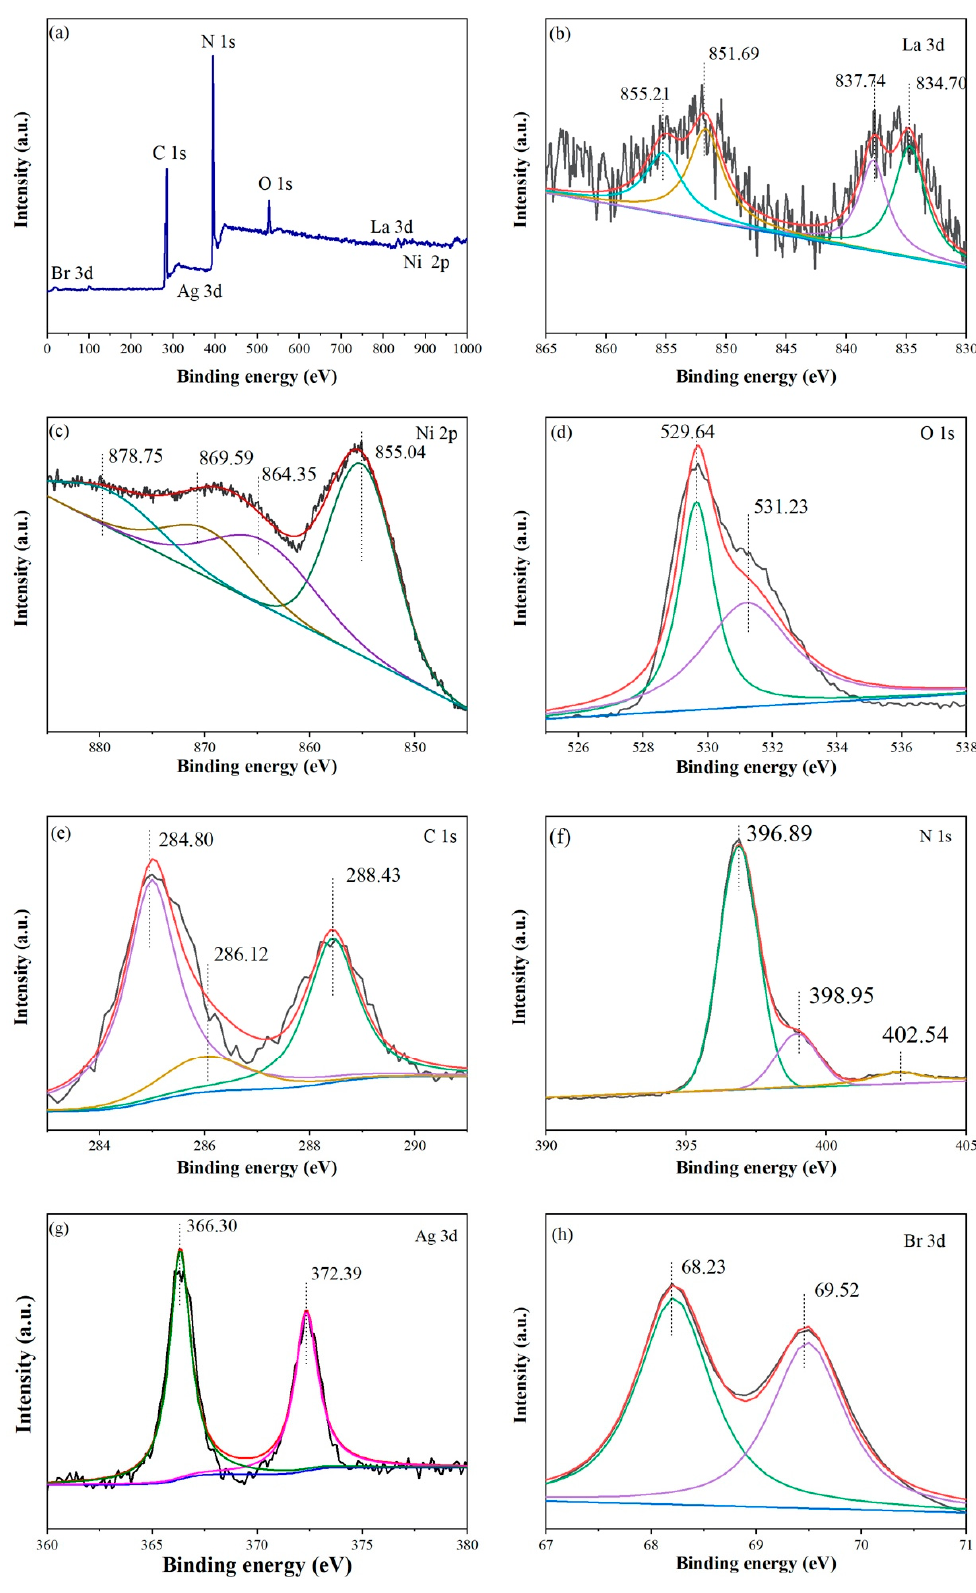
Figure 3. XPS spectra of as-obtained 3-ALG ( a ), La 3d ( b ), Ni 2p ( c ), O 1s ( d ), C 1s ( e ), N 1s ( f ), Ag 3d ( g ), and Br 3d ( h ).